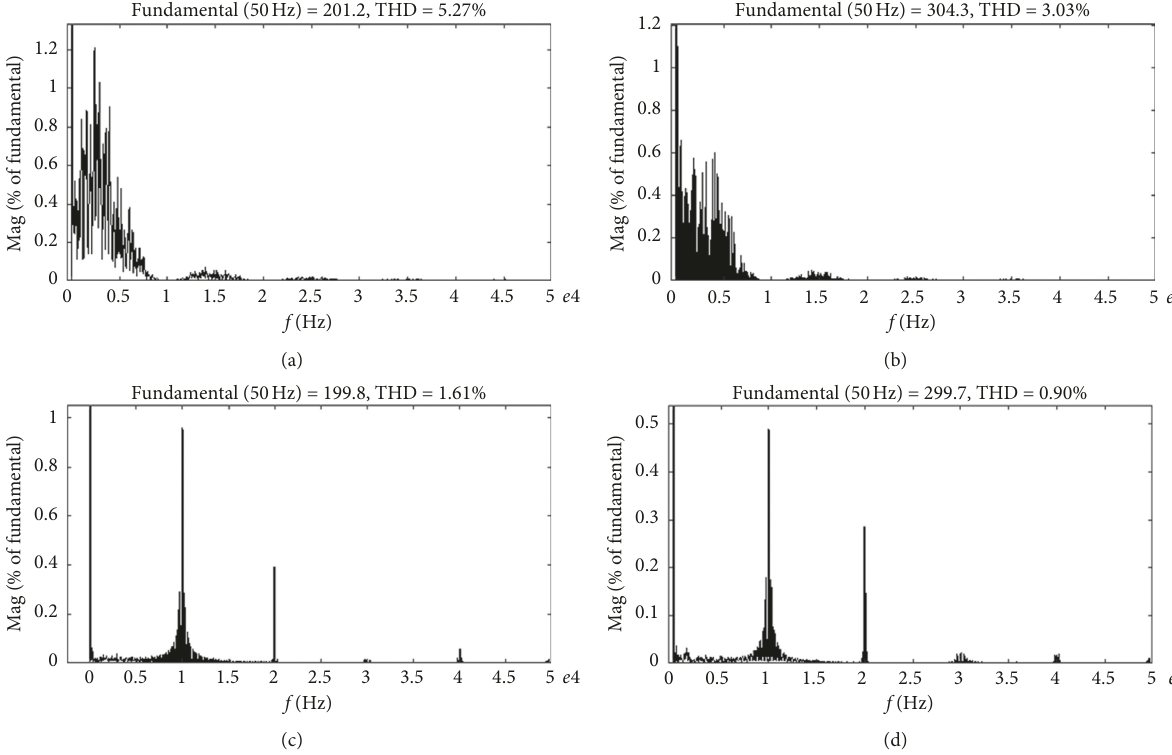
Figure 10: The fast Fourier transform analysis of the phase current. (a) The conventional MPC-RCMV ( i ∗ � 300 A). (c) The proposed MPC-RCMV ( i ∗ MPC-RCMV ( i ∗ s